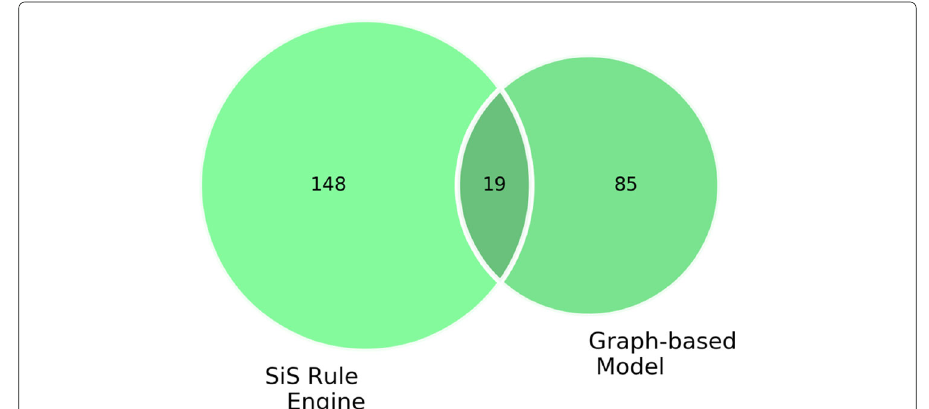
Fig. 10 Distribution of “high” legitimacy label. The high legitimacy label corresponds to a trusted transaction